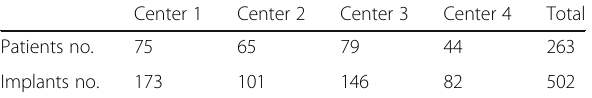
Table 1 Number of patients treated and implants inserted in each center of the present retrospective multi-centric analysis Center 1 Center 2 Center 3 Center 4 Total Patients no. 75 65 79 44 263 Implants no. 173 101 146 82